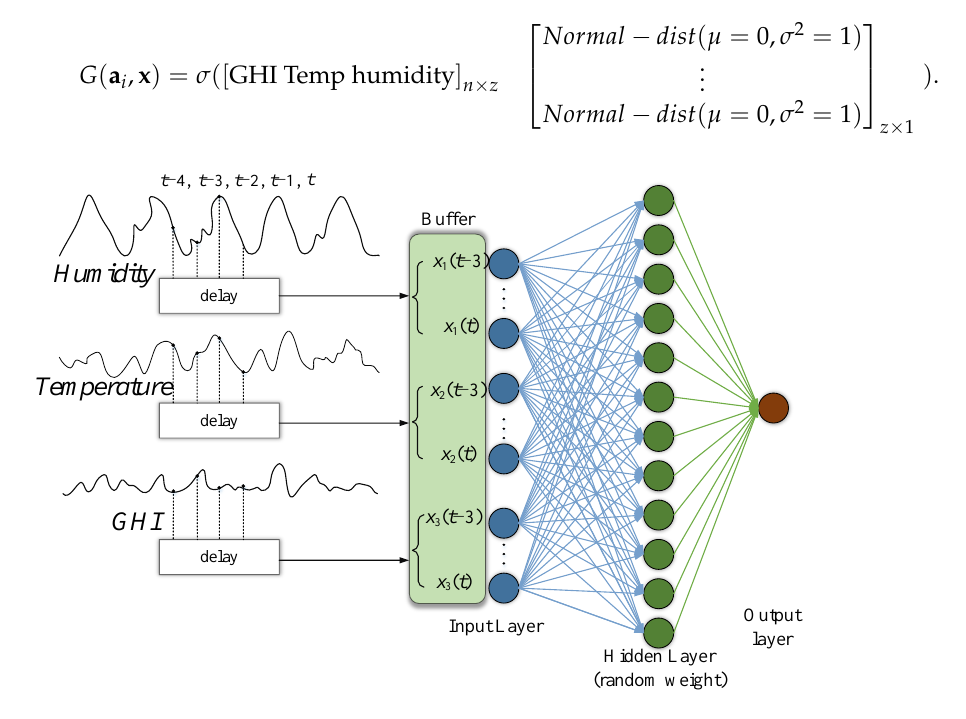
Figure 6. Extreme Learning Machine with time series input and sliding